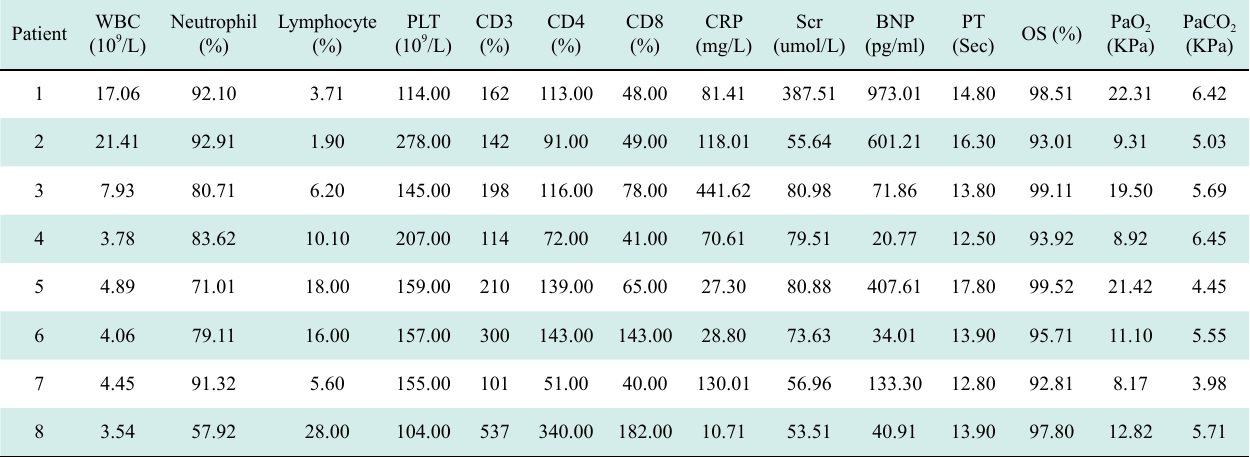
Table 2 Laboratory findings of patients infected with COVID-19 on admission to hospital